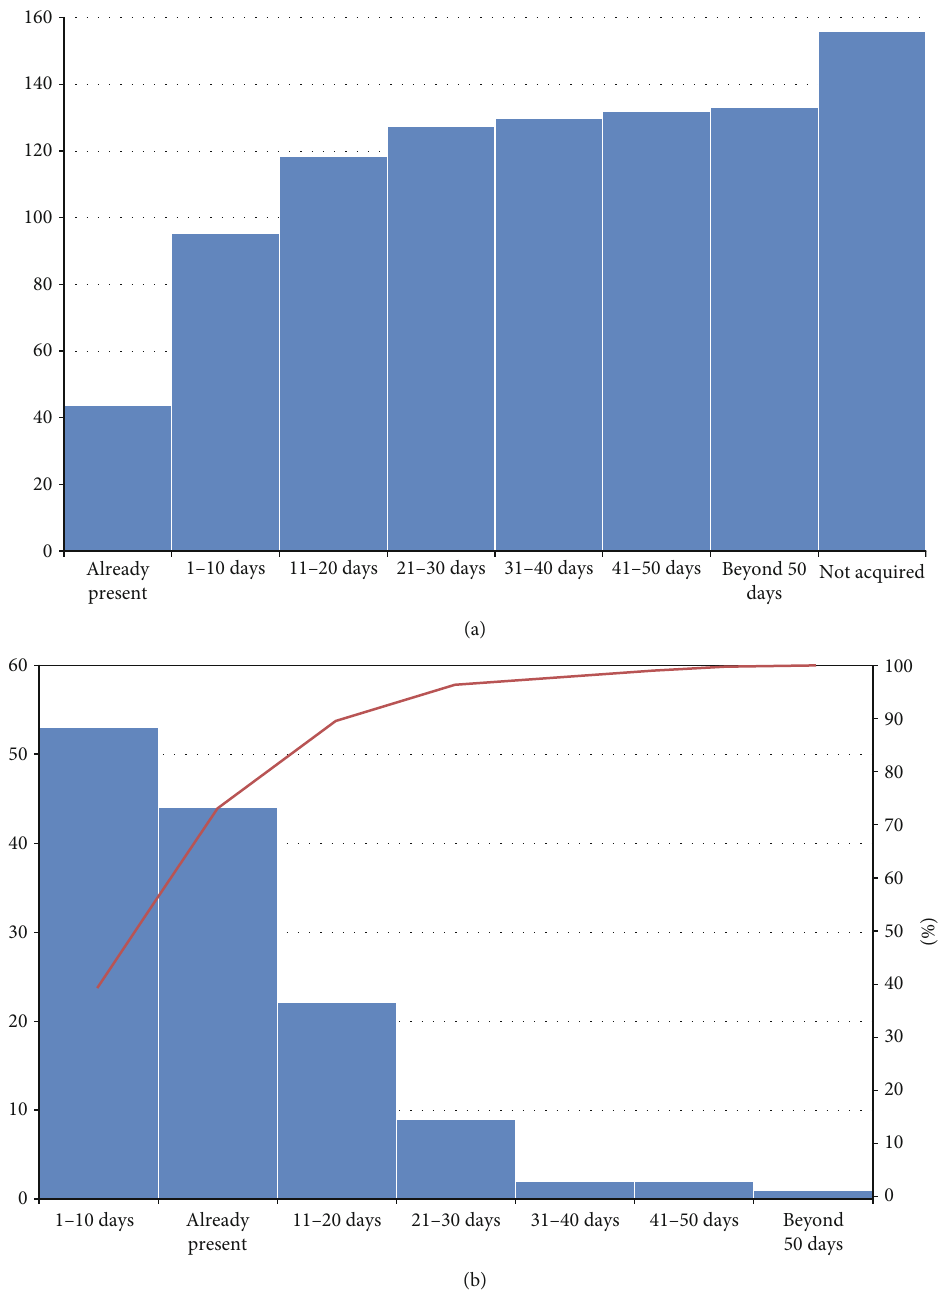
Figure 2: (a) Cumulative frequencies of autonomous standing acquisition times; abscissa, times of milestone acquisition; ordinate, absolute number of patients. (b) Single frequencies of milestone acquisition, ordered according to their frequency; columns, absolute number of patients; line, cumulative